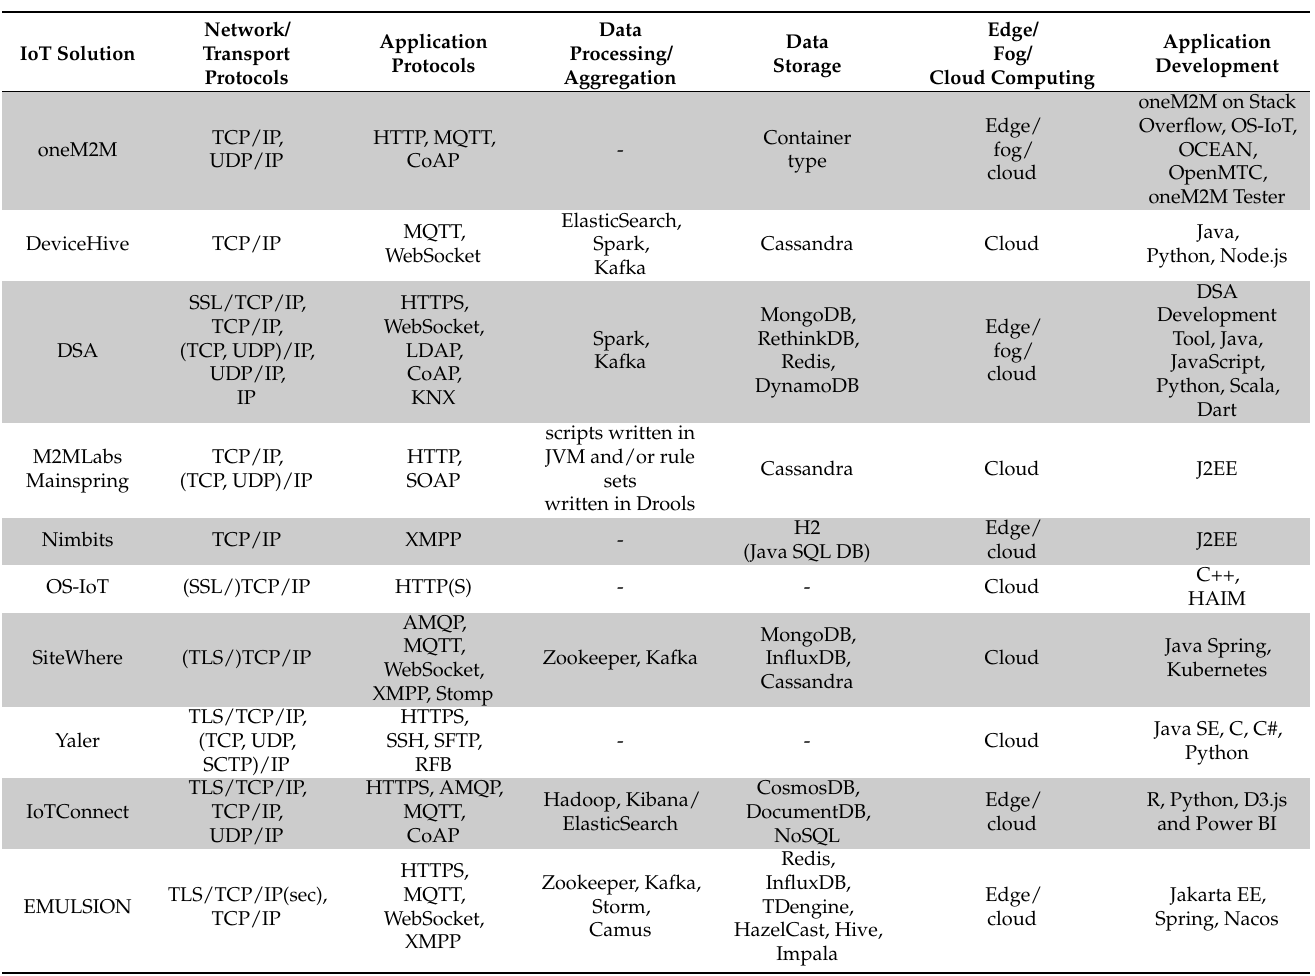
Table 1. Comparison of horizontal IoT platform solutions, based on underlying protocols and technologies